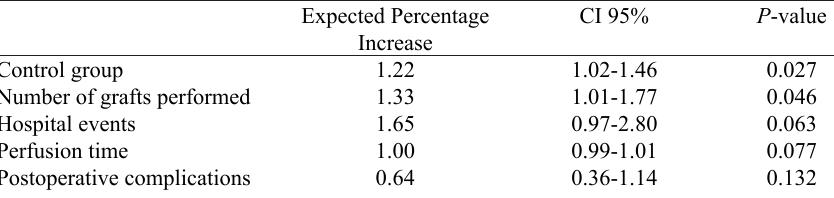
Table 7. Results of the multivariate analysis of troponin I release at 12